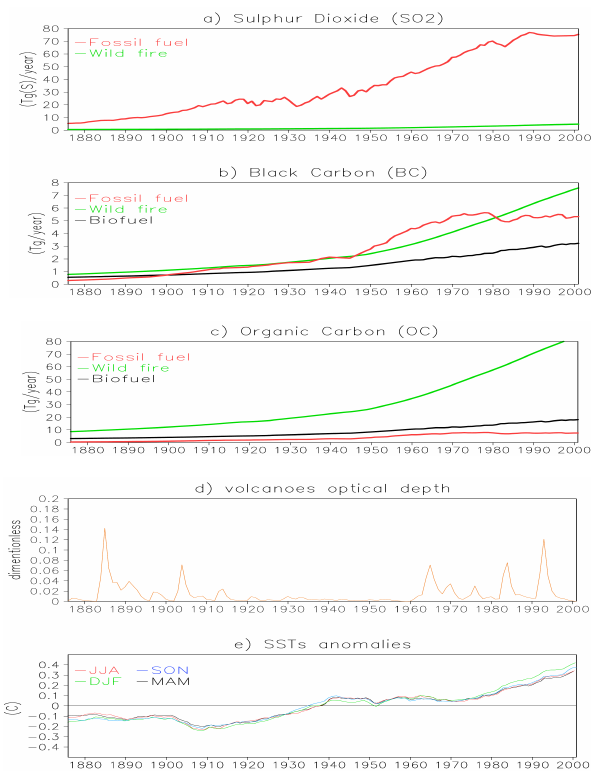
Fig. 1. Global annual time series of anthropogenic aerosol emis- sions (a–c) and stratospheric optical depth due to explosive volca- noes (d) , and global seasonal time series of SST anomalies shown as 11yr running means (e) . The SST anomalies are in ◦ C and corre- spond to the SST global mean value for each year, minus the global mean of the reference period